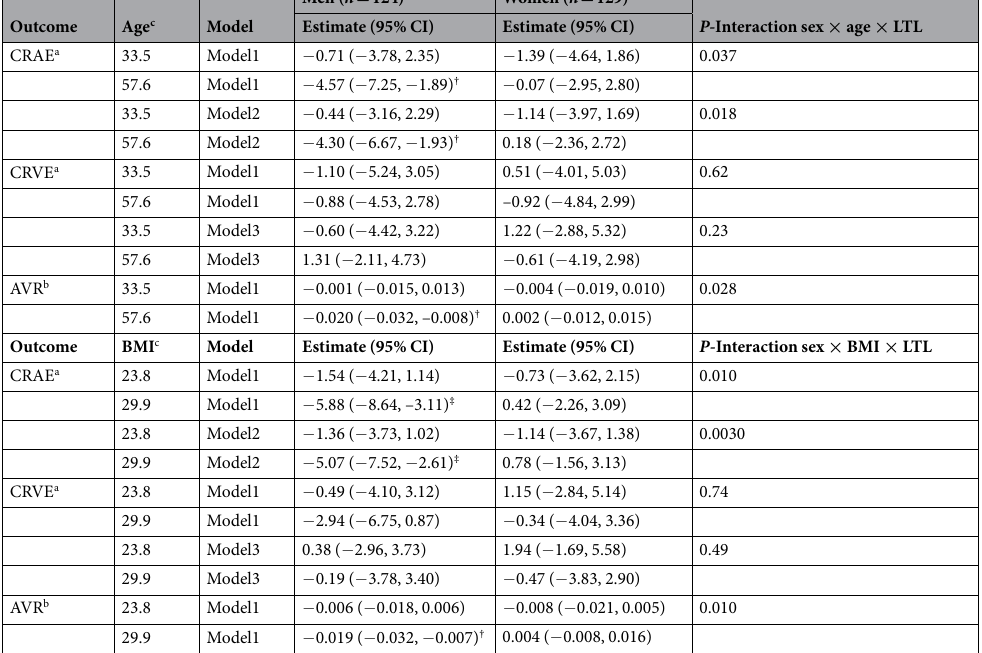
Table 2. Association between retinal diameters and leukocyte telomere length, stratified by sex, age or BMI. Abbreviations: BMI, body mass index; CI, confidence interval; LTL, leukocyte telomere length; CRAE, central retinal arteriolar equivalent; CRVE, central retinal venular equivalent; AVR, arteriole-to-venule ratio. Model 1 adjusted for age, sex, systolic blood pressure, smoking status, BMI as fixed effects and adjusted for participants nested within a family cluster as random effect. Model 2 adjusted according to Model 1 with additional adjustment for CRVE; Model 3 adjusted according to Model 1 with additional adjustment for CRAE; a Estimates presented as difference in arteriolar or venular diameter ( μ m) for a 20% shorter LTL. b Estimates presented as difference in arteriole-to-venule ratio for a 20% shorter LTL; c age in years and BMI in kg/m 2 provided for the 25th and 75th percentile. Significance for estimates: † P ≤ 0.01, ‡ P <